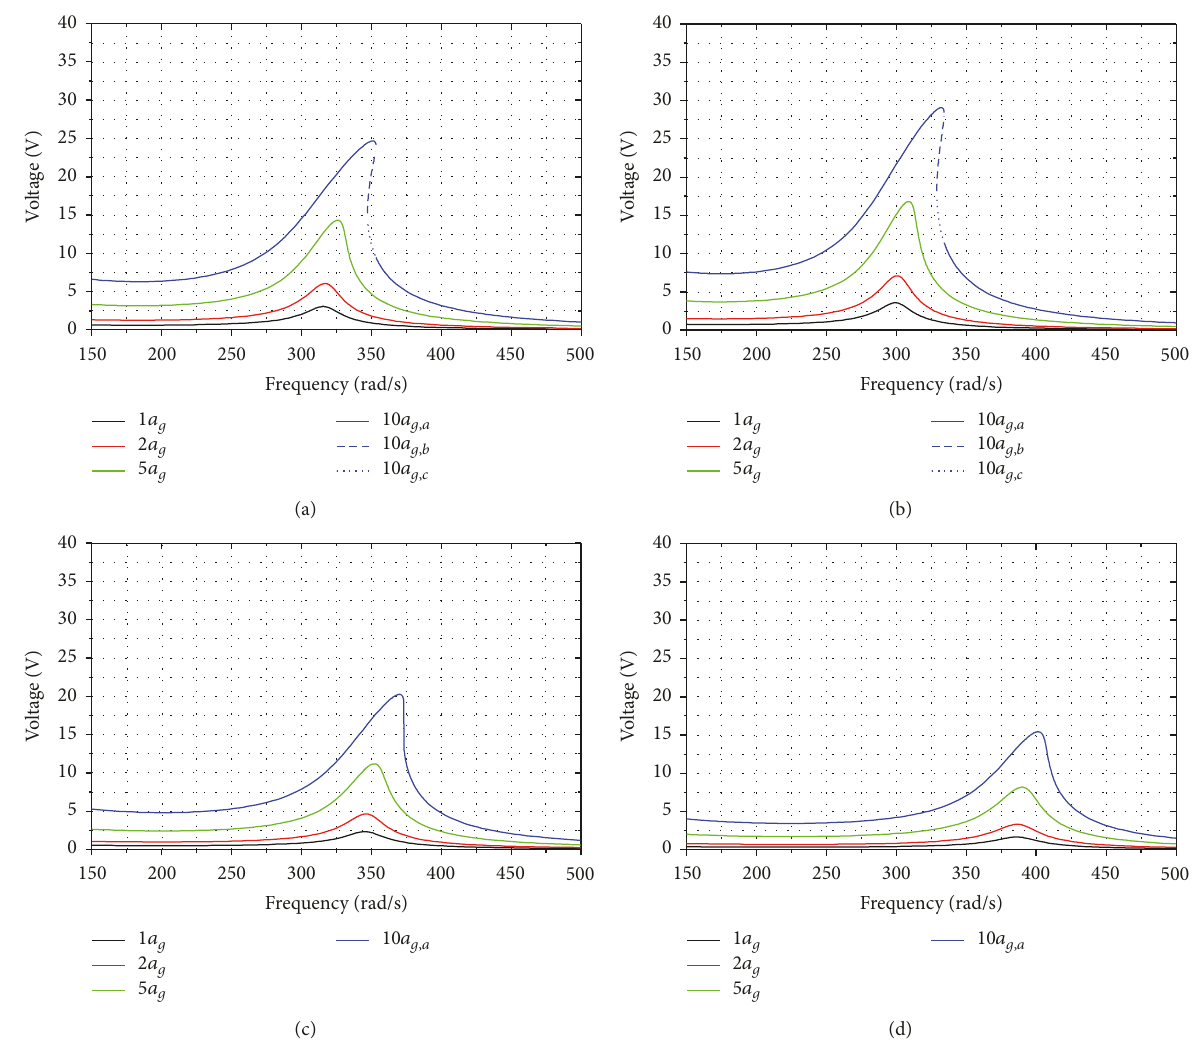
Figure 12: FRFs of the maximum voltage for base acceleration amplitudes ranging from 1 𝑎 𝑔 to 10 𝑎 𝑔 , where (a) 𝐸 mylar = 𝐸 0 mylar , (b) 𝐸 mylar = 0.5 𝐸 0 mylar , (c) 𝐸 mylar = 1.5 𝐸 0 mylar , and (d) 𝐸 mylar = 2.0 𝐸 0 mylar .